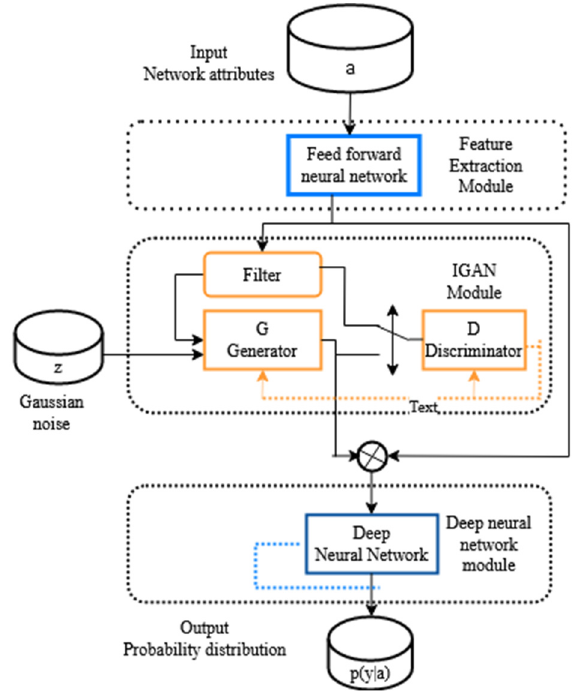
Figure 2. Architecture diagram of IGAN.